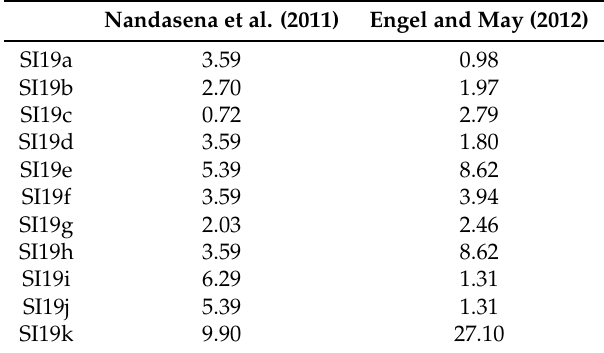
Table 4. Minimum wave heights H m required to displace the